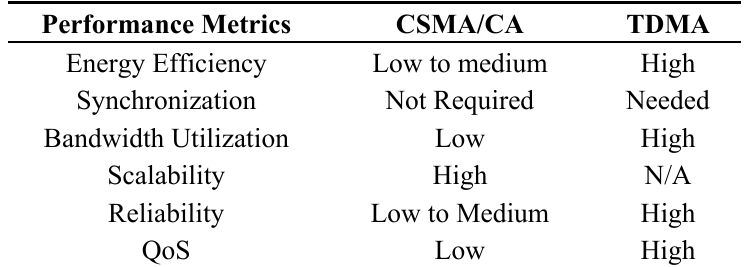
Table 8. Comparison of medium access